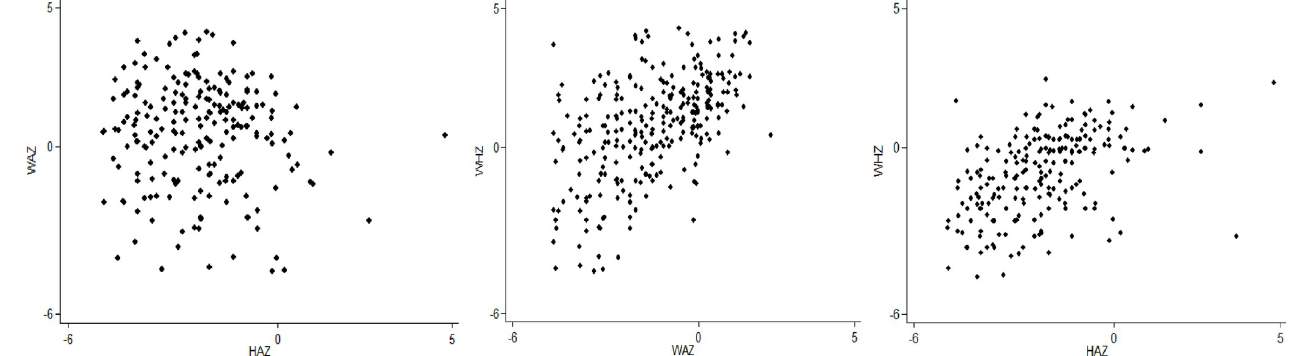
Fig 2. Correlation between different anthropometric indicators in district Rahimyar